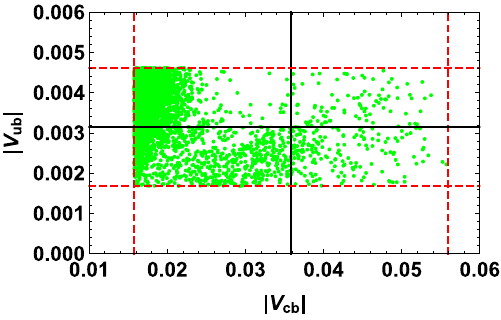
Fig. 2 Distribution on | V cb | – | V ub | plane where black lines denote observed central values of | V cb | and | V ub | , and red dashed-lines denote three times 1 σ interval